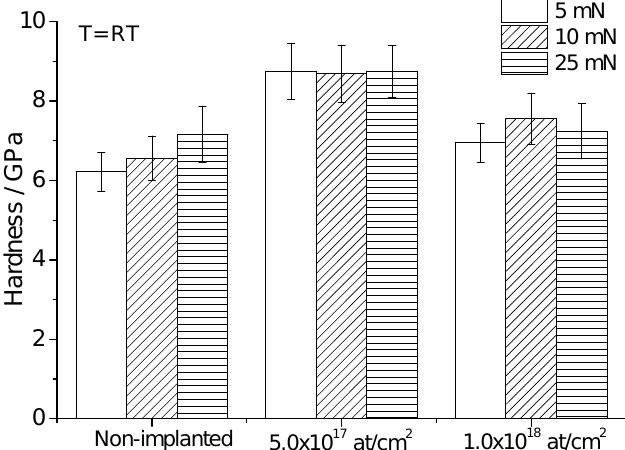
Figure 2. Hardness variation for the dies steel samples, non-implanted and implanted at room temperature, with normal loads of 5, 10 and 25